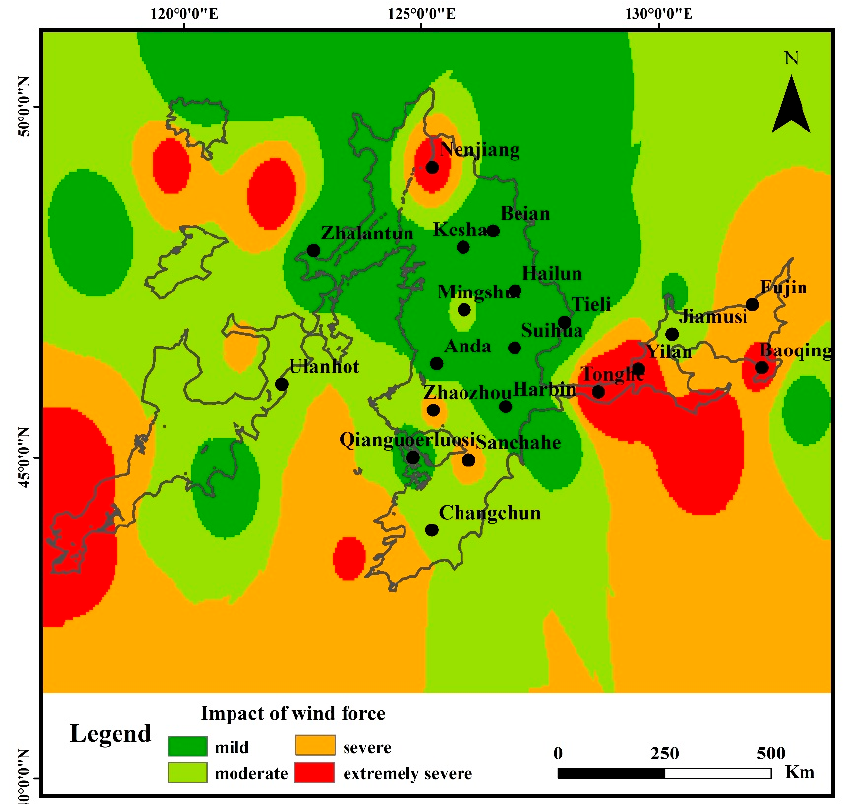
Figure 10. The degree of wind impacts in water erosion area of the typical black soil region.